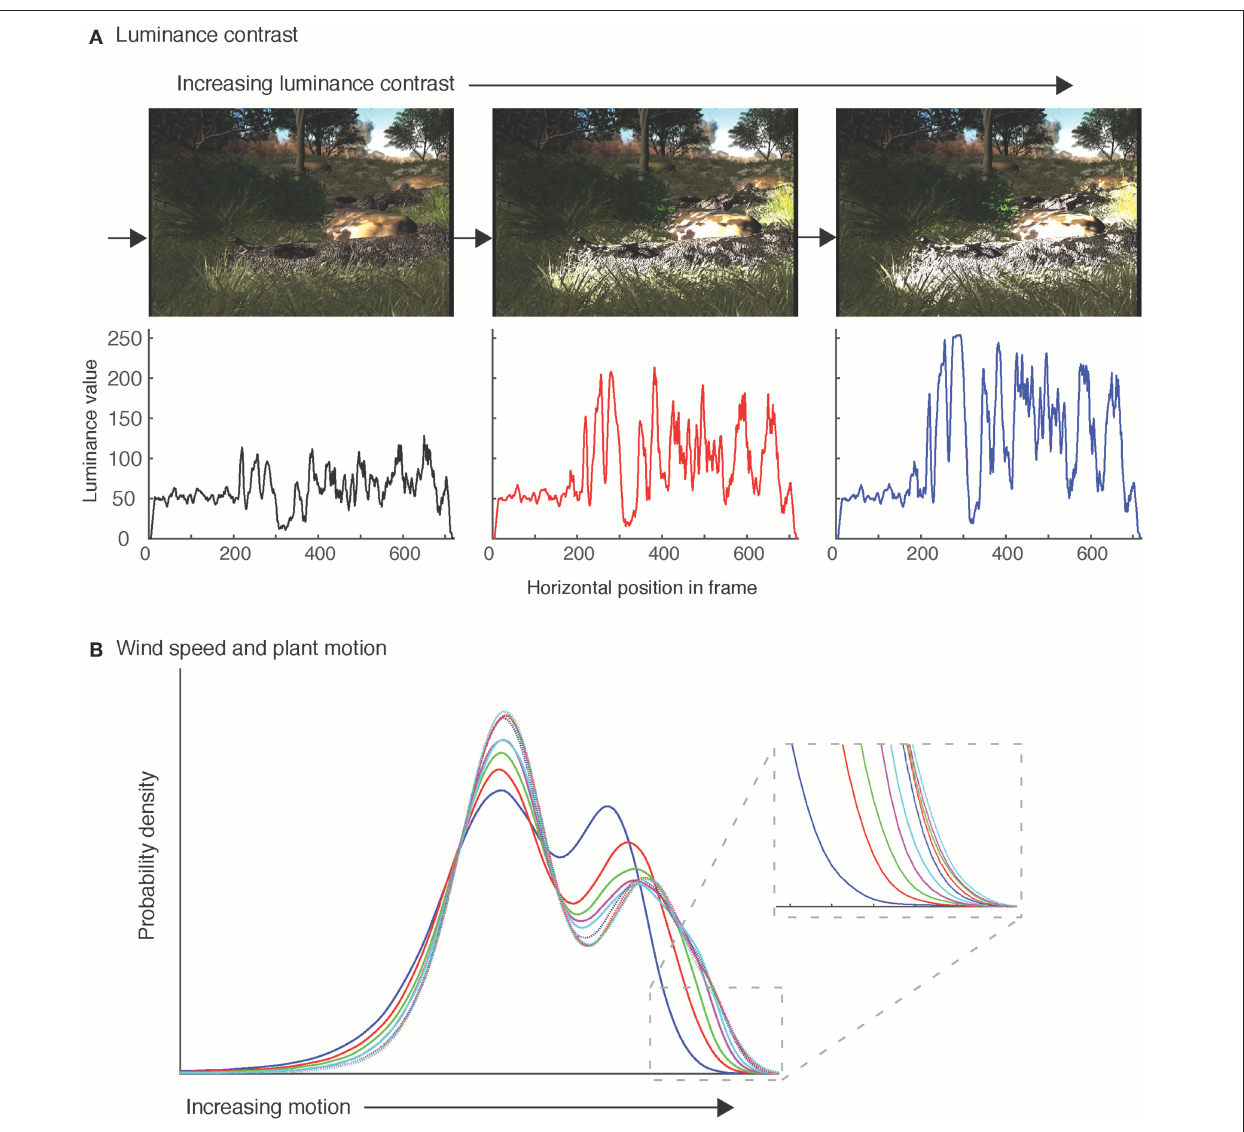
FIGURE 2 | The animation environment enables control of light and wind-induced plant motion. (A) Representative frames for varying light conditions (levels 1, 4, and 7). Below each image is the horizontal luminance profile, corresponding to the position of the arrow in each frame. The luminance value is represented here by intensity values in the range [0–255] following grayscale conversion in Matlab. (B) Animation sequences featuring plant motion in the absence of lizard movements were analyzed using computational motion analysis (Peters et al., 2002). The resulting speed data for each frame was extracted and combined (ignoring time). We calculated kernel density estimates of these speeds using the ksdensity function in Matlab to generate a vector of relative probability of different image motion speeds (probability density). The probability density is plotted separately for all ten animation sequences (different line colors). Inset : Enlargement of the fast speed end of the distribution highlights the non-liner change across the set of